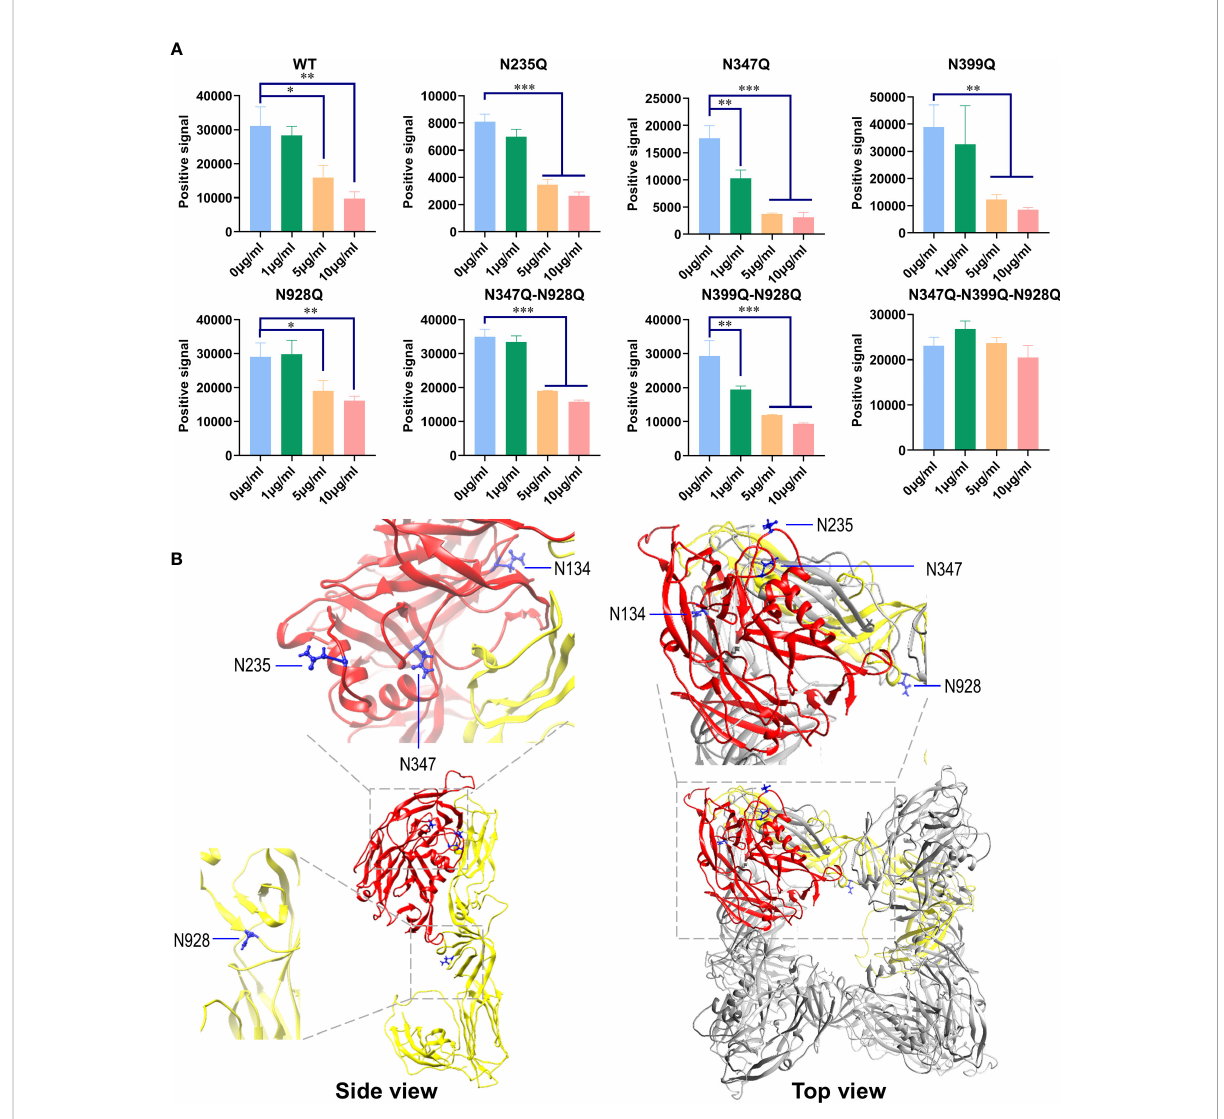
FIGURE 6 N -Linked glycosylation site on HTNV GPC is responsible for GRFT exerting HTNV inhibition effects. (A) HTNV GPC harboring different N -linked glycosylation site mutations was constructed using overlapping PCR. pVSV pseudotyped with these mutants was generated, and the infectious dose was normalized. Equal amounts of different pVSV-HTNV were pretreated with different concentrations of GRFT for 1 h and used to infect A549 cells. At 12 hpi, the GFP positive fi eld was imaged and calculated. Data shown in the graphs are presented as the mean ± SDs and are representative of three independent experiments, performed in triplicate. * p < 0.05, ** p < 0.01, *** p < 0.001. (B) The structure of the envelope glycoprotein perfusion complex of HTNV was modeled using the SWISS-MODEL program based on the envelope glycoprotein perfusion complex of the Andes virus (PDB: 6Y5F) and visualized using Chimera. Gn is colored red and Gc is yellow. The N -linked glycosylation residues, N134, N235, N347, and N928, are highlighted in blue. Except for N399, the corresponding ANDV N402 is missing in the original structure. HTNV, Hantaan virus; GPC, glycoprotein precursor; GRFT, grif fi thsin; pVSV, pseudotyped vesicular stomatitis